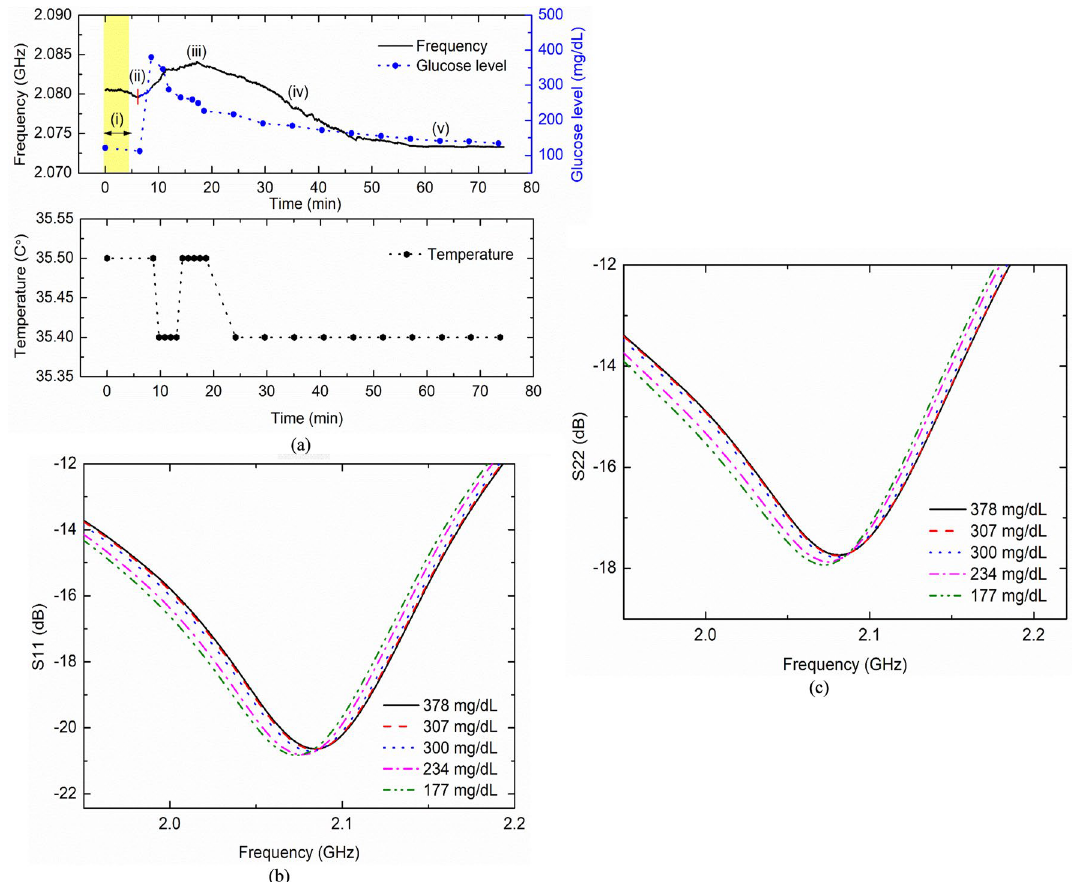
Figure 3. Results of the IVGTT conducted on a beagle. ( a) Sensor resonance frequency variation with real-time BGL: Sensor frequency (i) before glucose injection (ii) after glucose injection (iii) maximum point (iv) decreasing and following BGL (v) does not vary as BGL does not vary, also shown body temperature monitoring, ( b) S 11 and ( c) S 22 parameter of the sensor and corresponding